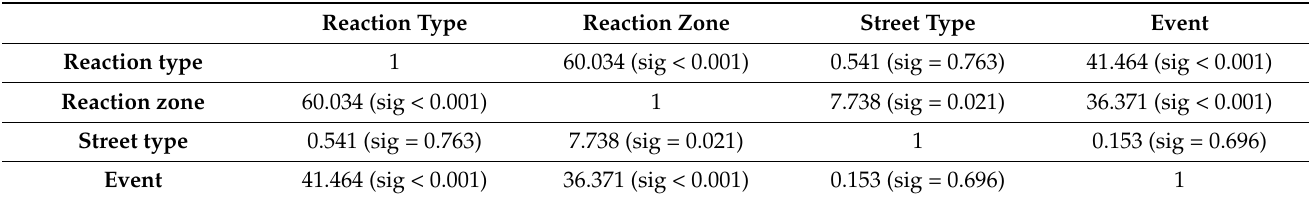
Table 6. Chi-square test results for categorical explaining variables and the response variable.